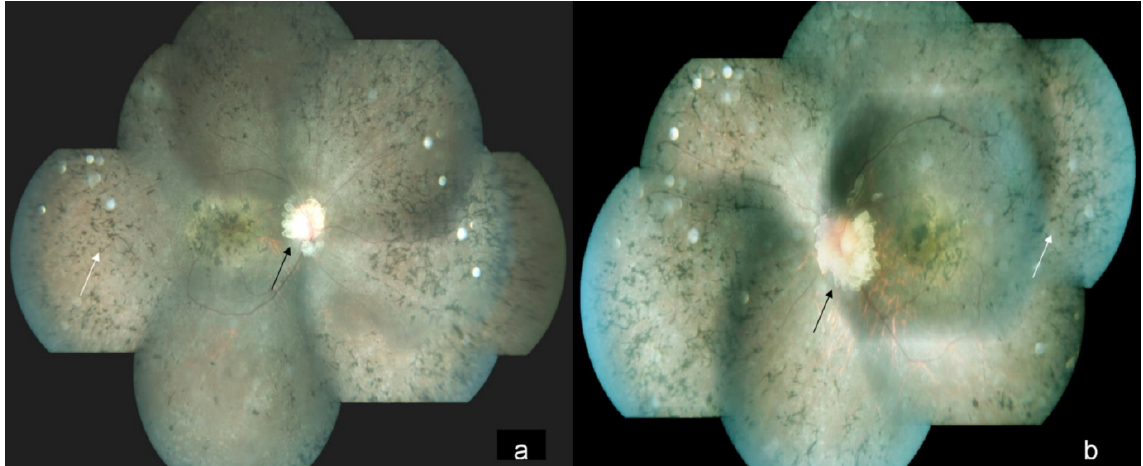
Figure 1: Color fundus photograph of the right eye (a) and the left eye (b) showing a creamy white, semitranslucent, elevated lesion surrounding the optic disc (a and b) (black arrow) along with bony spicules (a and b) (white arrow) in the mid periphery